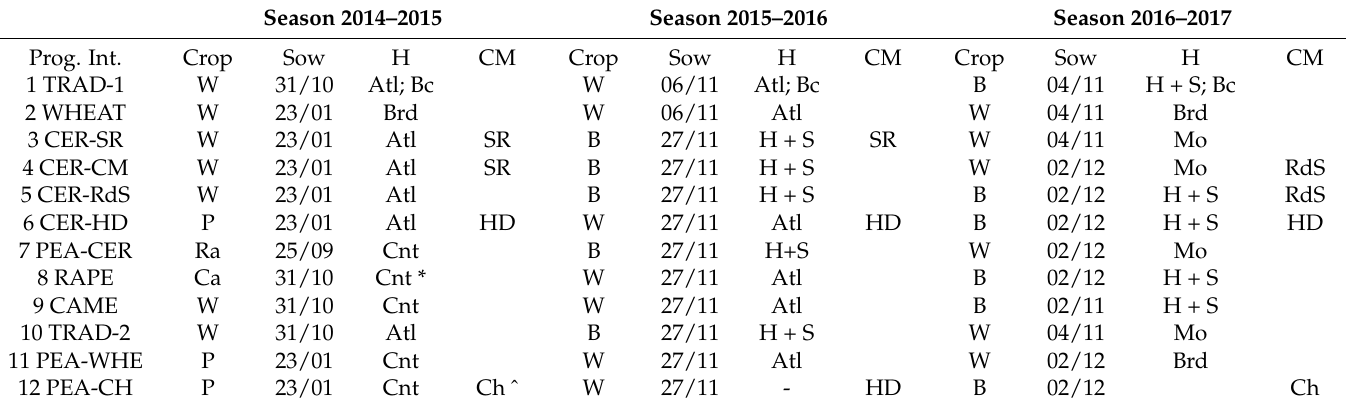
Table 1. Management details of each program during the three